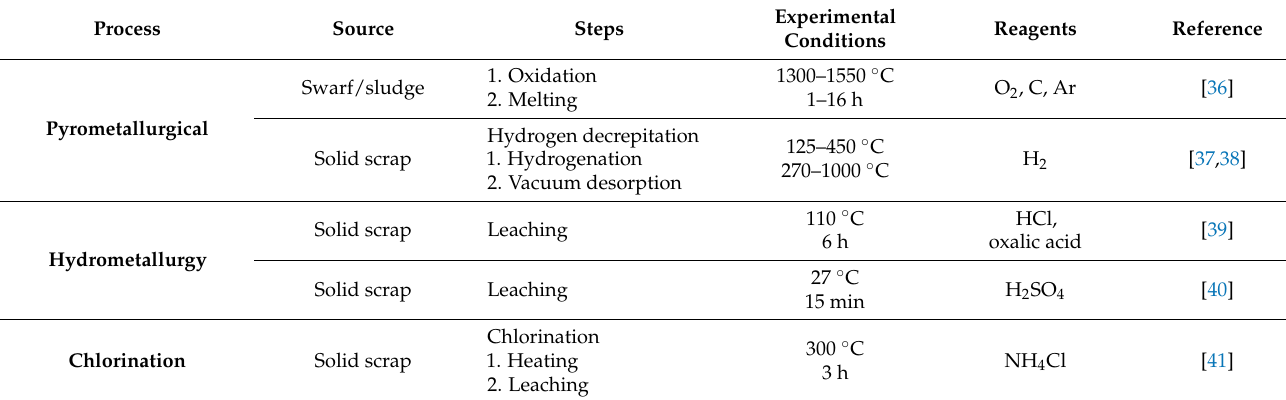
Table 2. Operating conditions of different recycling processes.